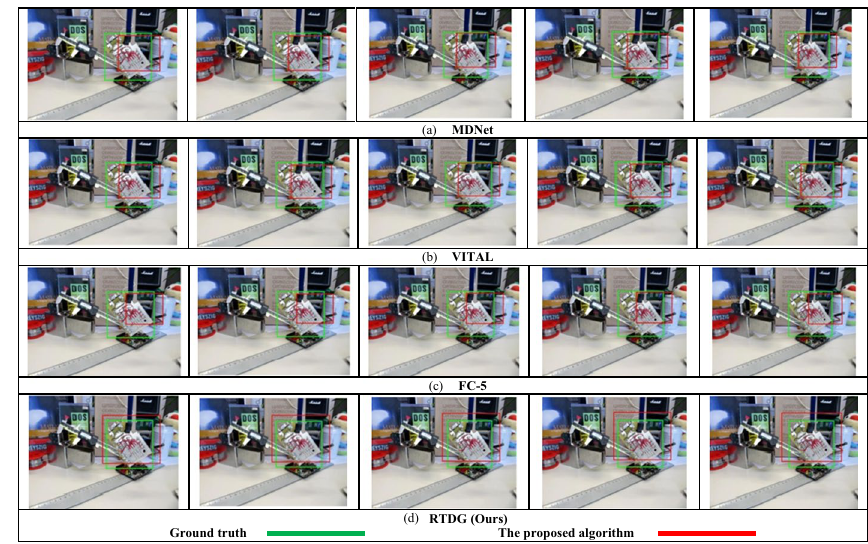
Fig. 9 Tracking results of the compared trackers on the ’Board’ video (frames: 547 to 551)